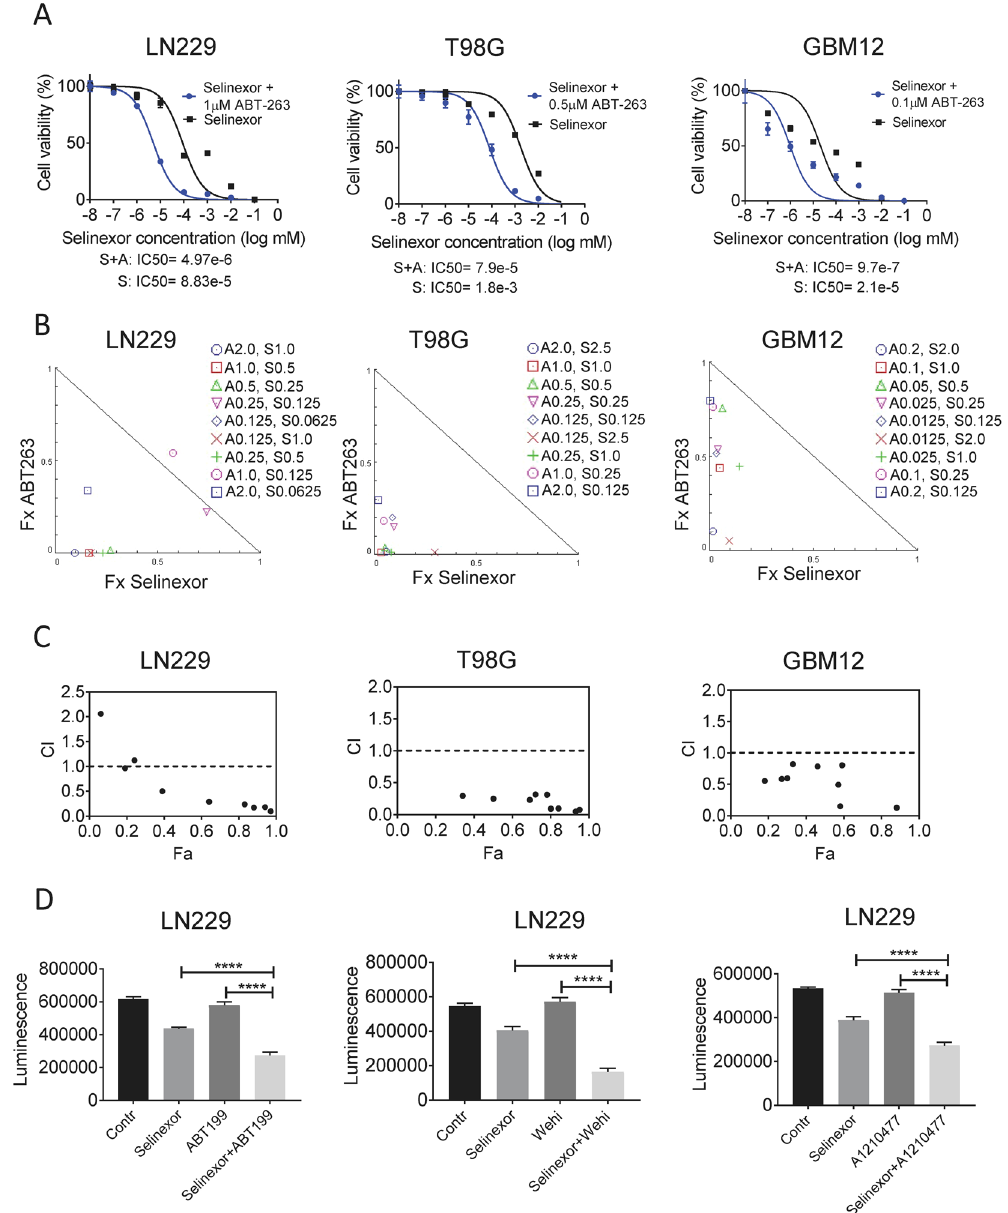
Figure 1. The combination treatment of BH3-mimetics and selinexor synergistically reduce cellular proliferation of glioblastoma cells. ( A ) The indicated glioblastoma cell lines, LN229, T98G and GBM12 (patient-derived xenograft) cells, were treated with increasing concentrations of selinexor in the presence or absence of the BH3- mimetic, ABT263, at 1 μ M. After 72 h, cell viability assays were performed and IC 50 values were calculated, using non-linear regression. Shown are means and SD. ( B ) LN229, T98G or GBM12 (patient-derived xenograft) cells were treated with a range of concentrations of ABT263, selinexor or the combination. 72 h after treatment, cell viability assays were performed and synergism analysis was performed. Shown are the isobolograms for the three different cell lines. Points below the border line are considered synergistic, whereas points above are antagonistic. Points on the line are additive. ( C ) LN229, T98G and GBM12 (patient-derived xenograft) cells were treated as in B. Shown is the combination index (CI) vs. the fractional response rate (Fa). CI values smaller than 1.0 indicate a synergistic interaction. ( D ) LN229 GBM cells were treated with selective BH3-mimetics, ABT199 (Bcl-2 inhibitor), WEHI-539 (Bcl-xL inhibitor) or A1210477 (Mcl-1 inhibitor) in the presence or absence of selinexor. Contr: Control, Shown are means and SD of total luminescence values. * p < 0.05; ** / *** / **** p <